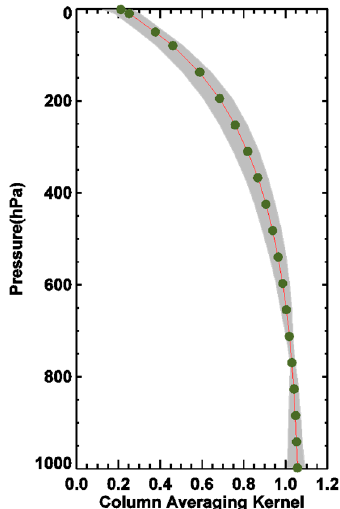
Figure 6. An example of a column averaging kernel for YCAR-CAI CO 2 retrieval. The shaded area indicates the variation range of the column averaging kernel over the Tsukuba and Saga TCCON sites. The solid line with dots shows the mean column averaging kernel.